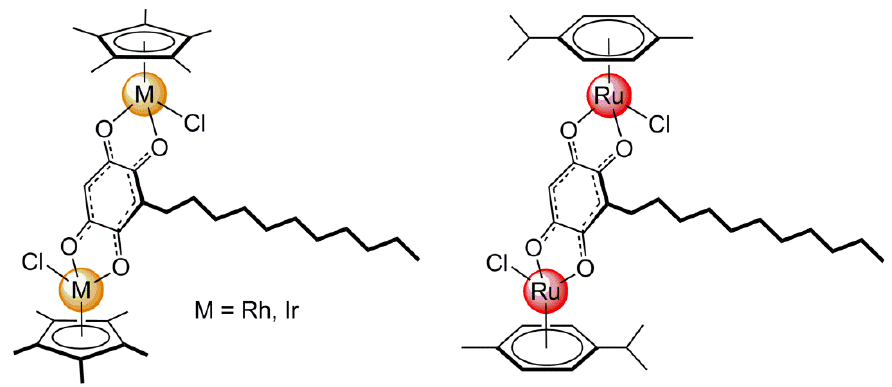
Figure 2. Molecular structure of embelin-derived dinuclear